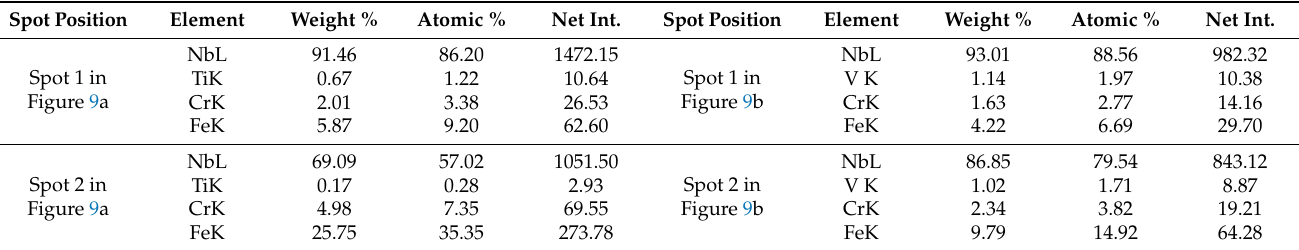
Table 3. EDS spot analyses of X6CrNiMoVNb11-2 steel before and after heat